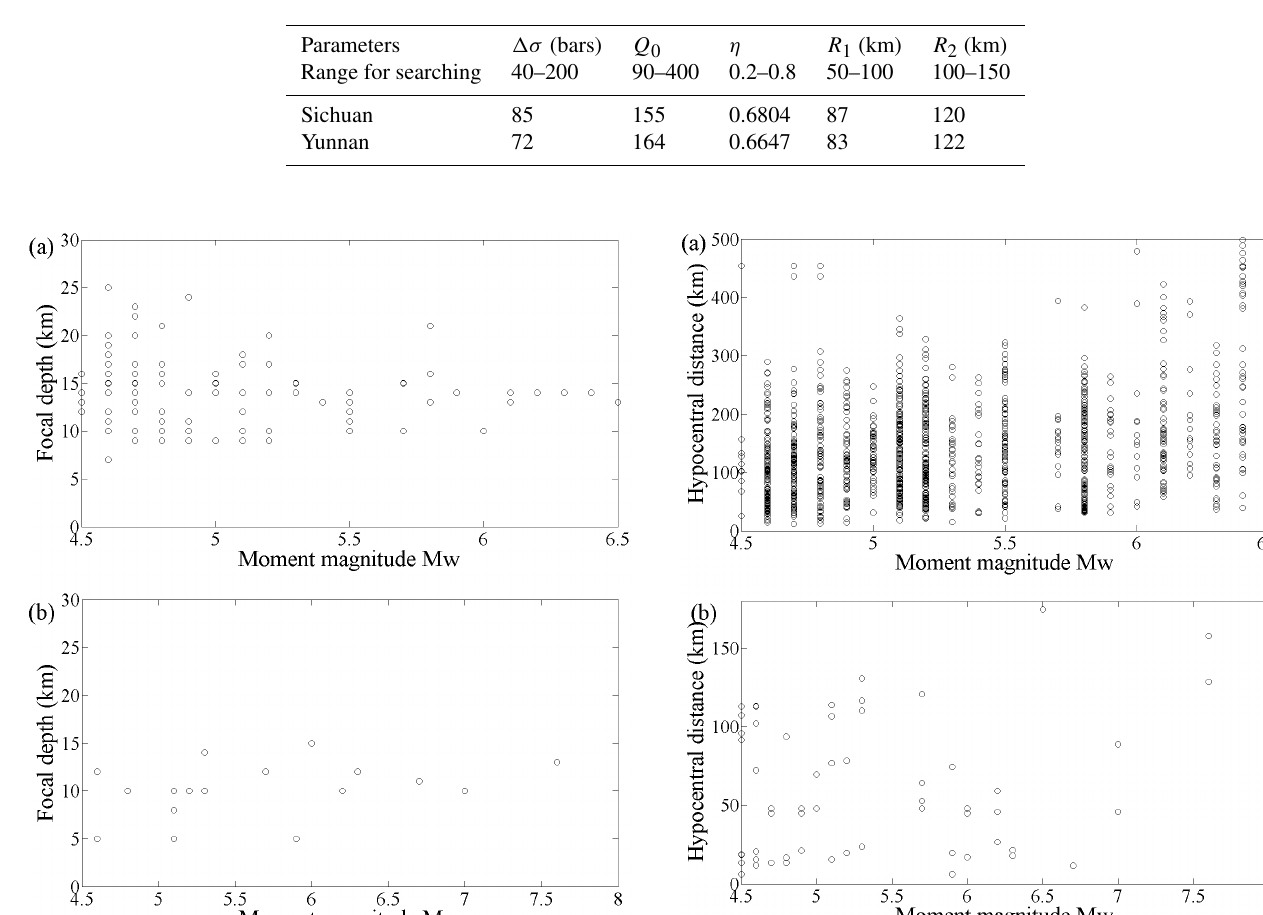
Table 1. Inverse results.